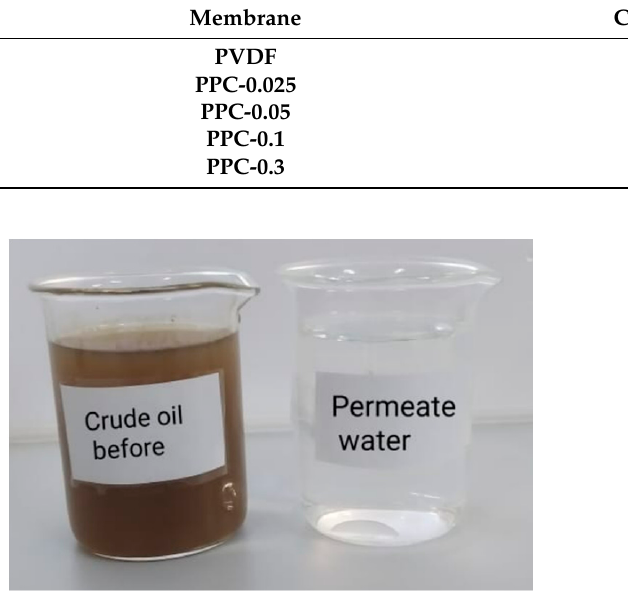
Figure 11. Feed and filtrate produced from a rejection of crude oil/water mixture. The separation process of crude oil wastewater using a membrane is a sieving pro- cess that relies on size exclusion, membrane surface hydrophilicity, and surface charges (electrostatic interaction) [69]. For the sieving effect, larger-sized oil droplets are blocked by smaller membrane pores; as noticed previously, the average membrane pores size is between (7.6 to 10.4) nm, while the measured oil droplets size was about 400 nm.